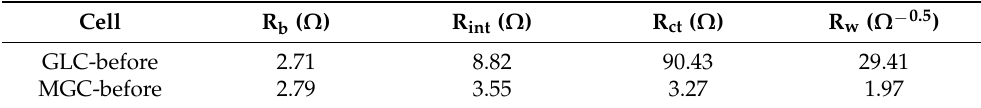
Figure 4. ( a ) Galvanostatic cycling with potential limitation (GCPL) profile at 1 mA cm − 2 and 5th cycle, ( b ) cyclic voltammetry (CV) curves of GLC and MGC, electrochemical impedance spectra (EIS) of ( c ) GLC and MGC before cycling, ( d ) GLC and MGC after cycling. Table 3. EIS fitting results using a CPE model.